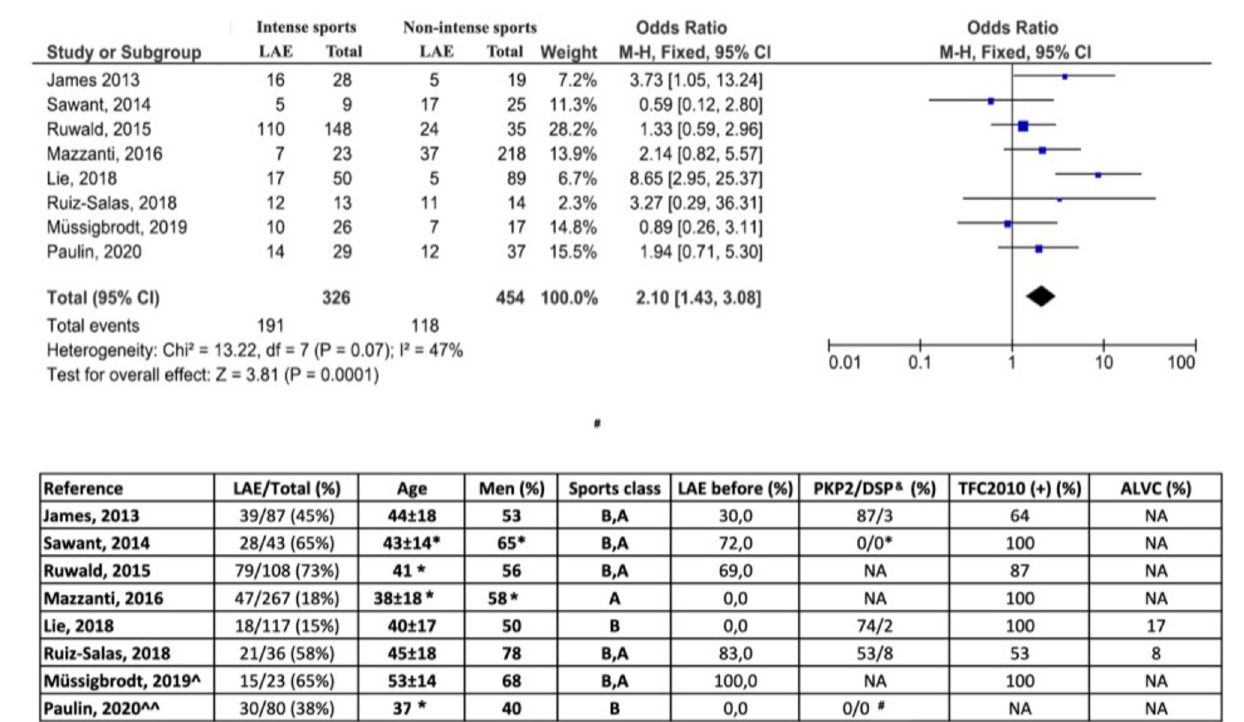
FIGURE 4 | Forest plot represents standardized (5-year) rate of life-threatening arrhythmic events (LAE) and 95% CI from eight selected studies referenced in the text. Odds ratios for intense vs. non-intense exercise were calculated per study. Pooled data represented in the bottom black diamond (Review Manager 5.4). Bottom table summarizes relevant extracted demographic and clinical data from the eight selected articles. N, number; Y, years; FU, follow-up; TFC2010, Definite Task Force Criteria for arrhythmogenic right ventricular cardiomyopathy; ALVC, arrhythmogenic left ventricular cardiomyopathy; ∧ VT ablation series, ∧∧ ICD series, primary prophylaxis. Sports class: sports classification depending on physical activity before (B)/after (A) recruitment. & Data referred to the total sample size referred at the second column, even though some patients may not have had genetic studies performed and, if done, others may not have mutation identified. * Figure